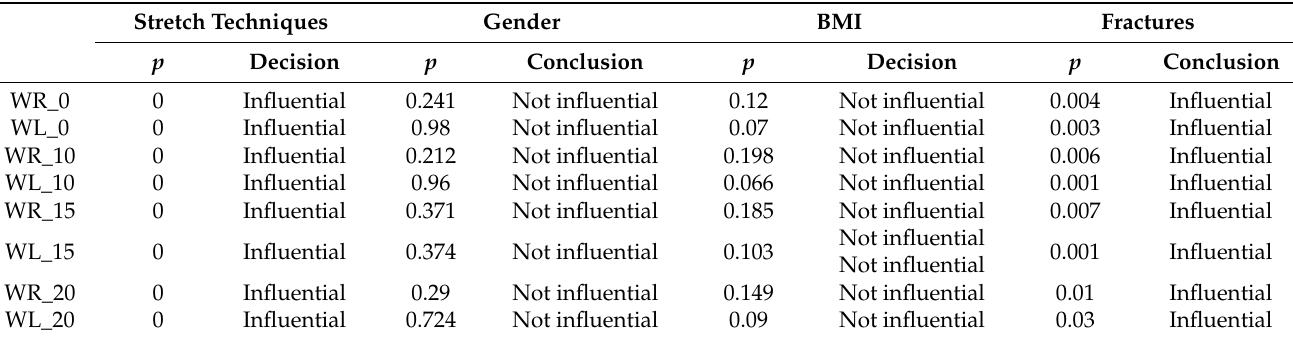
Table 2. Kruskal–Wallis test.